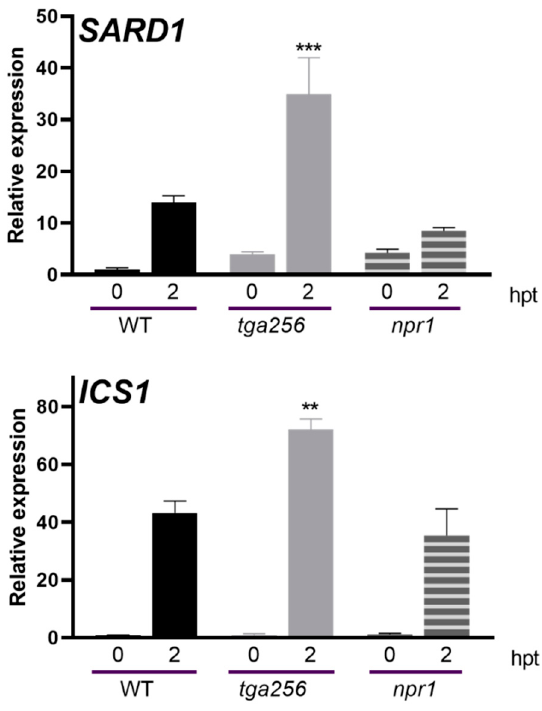
Figure 7. NPR1 does not participate in the regulation of genes related to SA accumulation under stress. Fifteen-day-old WT, tga2-1 / tga5-1 / tga6-1 ( tga256 ), and npr1-1 ( npr1 ) mutant seedlings were treated with UV-C. Non-irradiated seedlings were used as control (0). Treated seedlings were frozen at 2 h post treatment (hpt). RNA was extracted, and the SARD1 and ICS1 gene expression was evaluated by RT-qPCR. Bars represent the mean of the relative expression ± SEM from four biological replicates. Asterisks indicate statistically significant differences between the mutant genotypes and the WT plants according to a 2-way ANOVA analysis and Sidak’s post-test (**: p < 0.01, ***: p < 0.001).